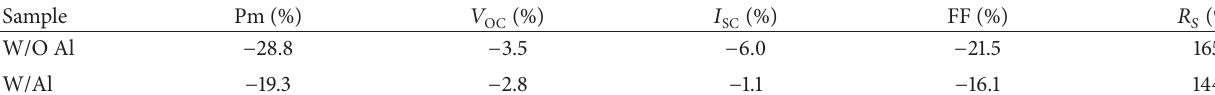
Table 2: Changes in normalized electrical parameters of PV modules with and without Al after 2500 h.